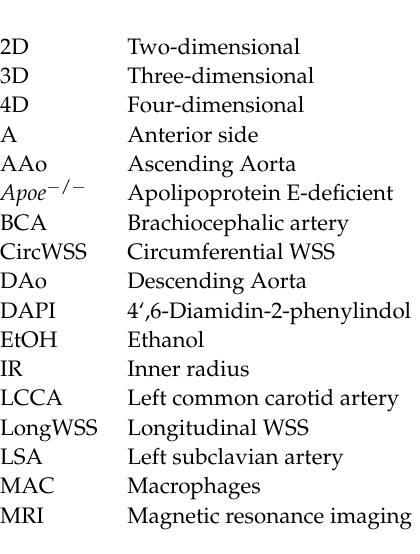
values for wildtype and Apoe − / − mice over time. Figure S3: Intergroup comparison of LongWSS for all measurement time points. Figure S4: Intergroup comparison of CircWSS for all measure- ment time points. Figure S5: Radial strain shows modest changes in Apoe − / − and WT mice over time. Figure S6: Intergroup comparison of RadStrain for all measurement time points. Figure S7: Intergroup comparison of OSI for all measurement time points. Figure S8: Histological stainings of longitudinal sections of an exemplary Apoe − / − mouse. Table S1: Spatial median, lower quartile and upper quartile values of the intragroup standard deviations (STD) in wild type mice, determined from the pixel values of the 2D projection maps. Table S2: Spatial median, lower quartile and upper quartile values of the intra group standard deviations (STD) in Apoe − / − mice, determined from the pixel values of the 2D projection